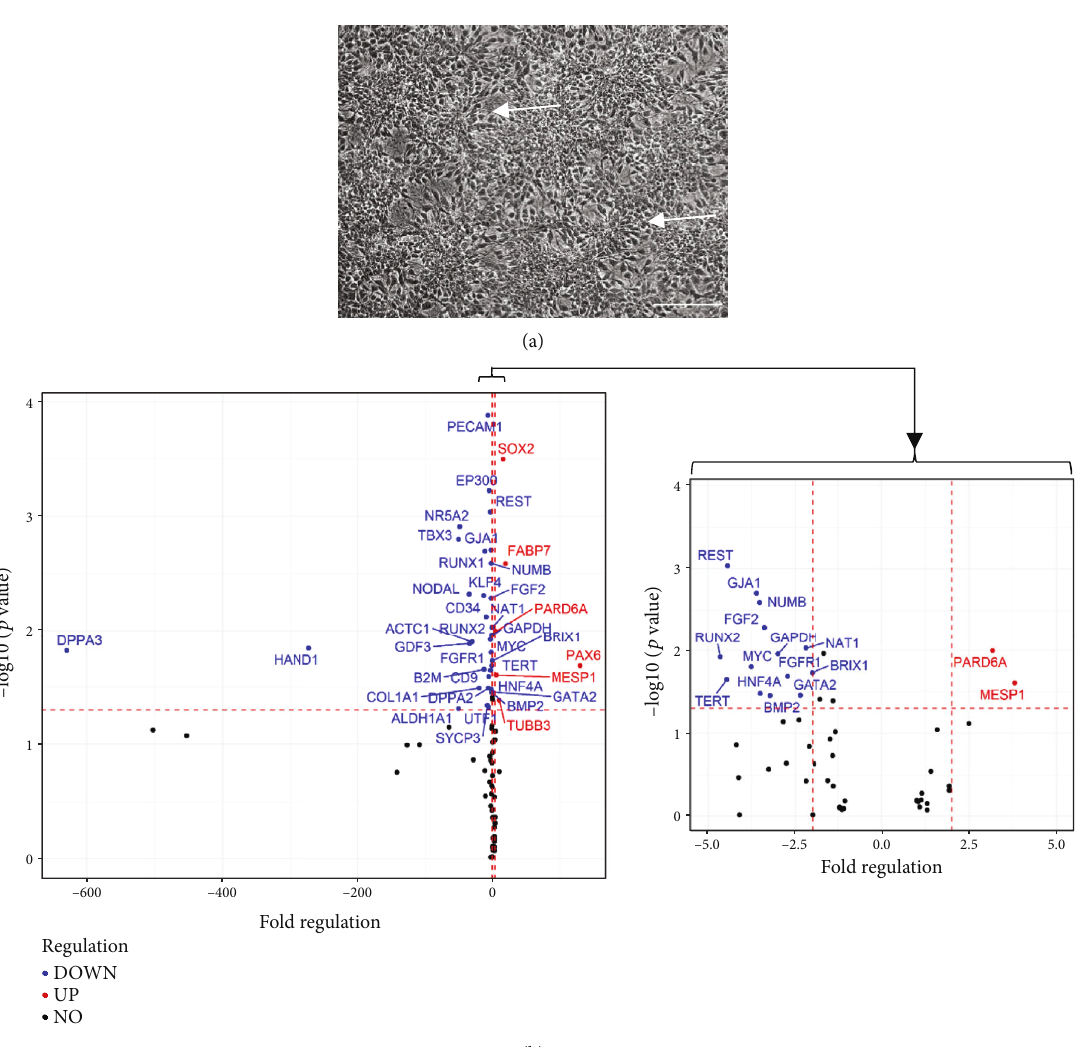
Figure 1: NPC di ff erentiation from hiPSC for the generation of mature MNs. (a) NPC form neural rosettes illustrated in a representative phase-contrast image. Scale bar, 200 μ m. (b) Identity of NPC assessed by signi fi cant upregulation of genes involved in neurogenesis and downregulation of genes coding for pluripotency compared to hiPSC. Fold regulation of genes ( ≥ 2.0 or ≤ -2.0 in combination with p < 0 : 05 ) is shown as means ( n = three independent experiments). The horizontal red dashed line indicates a p value of 0.05 whereas the vertical red dashed lines correspond to a fold regulation of -2.0 and 2.0, respectively. For better illustration, the range between -5.0 and 5.0 is additionally